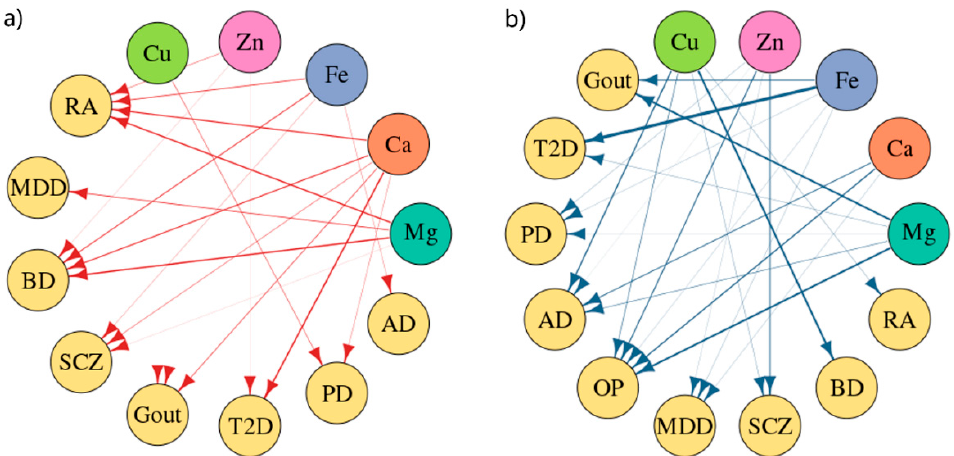
Figure 4. MR estimates of the positive-negative trend causality network diagram of minerals and diseases: ( a ) Positive correlation trend graph. ( b ) Negative correlation trend graph. The line thickness represents the logarithm of the p value of the causality: a thicker line represents a more significant p value. OP is present only in negative correlation networks because minerals have a negative effect on OP only.